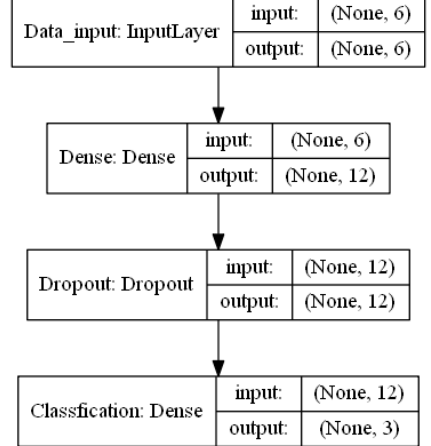
Figure 7. Classification model based on back-propagation neural network (BPNN).